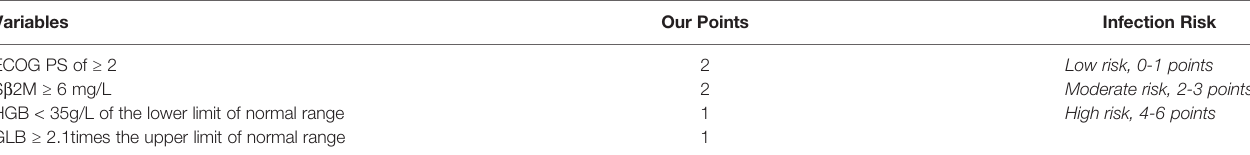
TABLE 3 | The parameters and groupings of our IRMM.